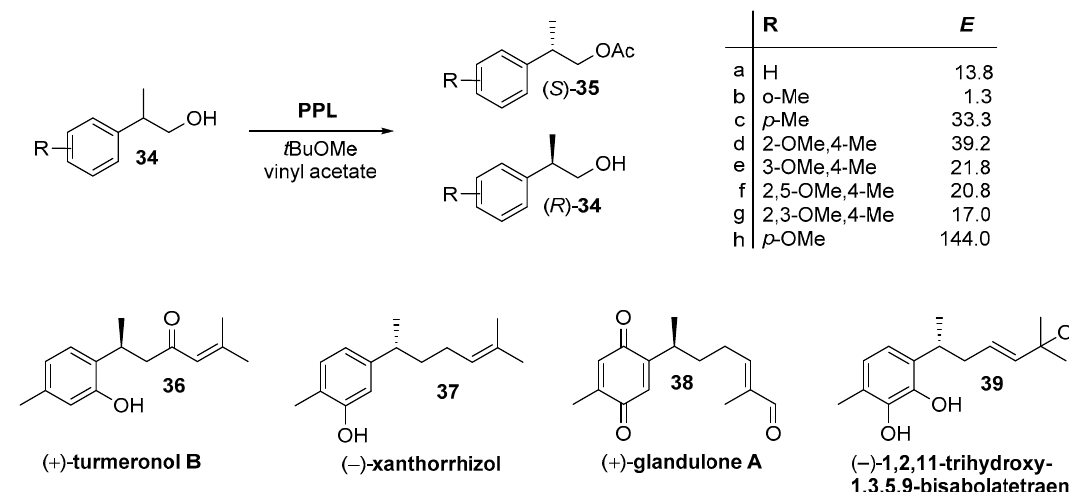
Figure 7. Lipase-mediated resolution of substituted 2-aryl-propanols ( 34 ). The effect of the aromatic ring substituents on the enantioselectivity. Chiral building blocks ( R )- 34d , ( S )- 35e , ( R )- 34f , and ( S )- 35g were used for the synthesis of the bisabolane sesquiterpenes (+)-turmeronol B ( 36 ), ( − )-xanthorrhizol ( 37 ), (+)-glandulone A ( 38 ), and ( − )-1,2,11-trihydroxy-1,3,5,9-bisabolatetraene ( 39 ), respectively.